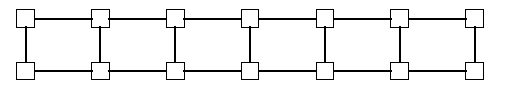
Figure 4: A 2D lattice model partition function is shown as a tensor network on a 7 × 2 square lattice. This model does not suffer from rank explosion because it is effectively one-dimensional.